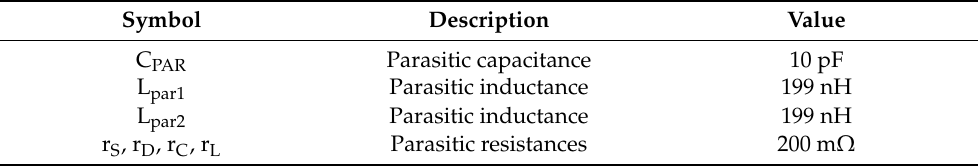
Table 2. Values of the parasitic components of the Boost converter Model MCP1640EV-SBC.